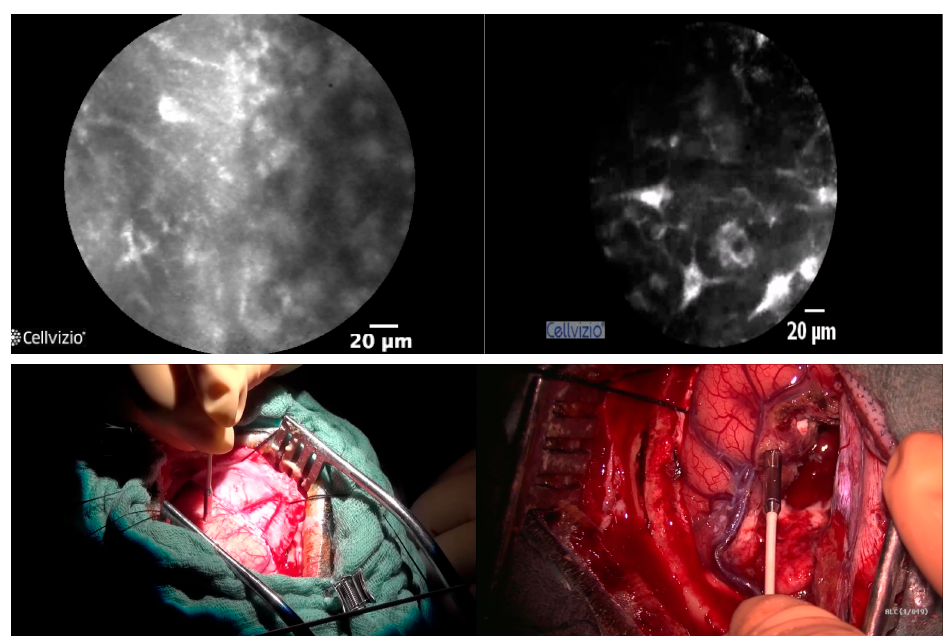
Figure 2. State-of-the-art visualization of the brain today is 10-fold magnification without cell visualization (pictures below ). With CLE, we can see tumor borders (above left ) and tumor-free zone at the end of the surgery (above right ).